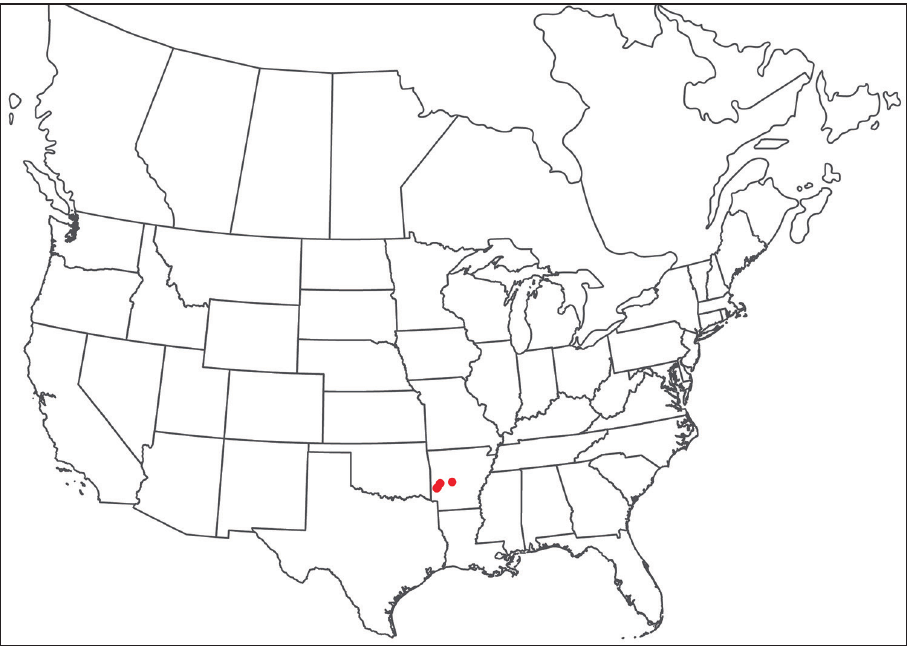
Figure 126. Torrenticola larvata